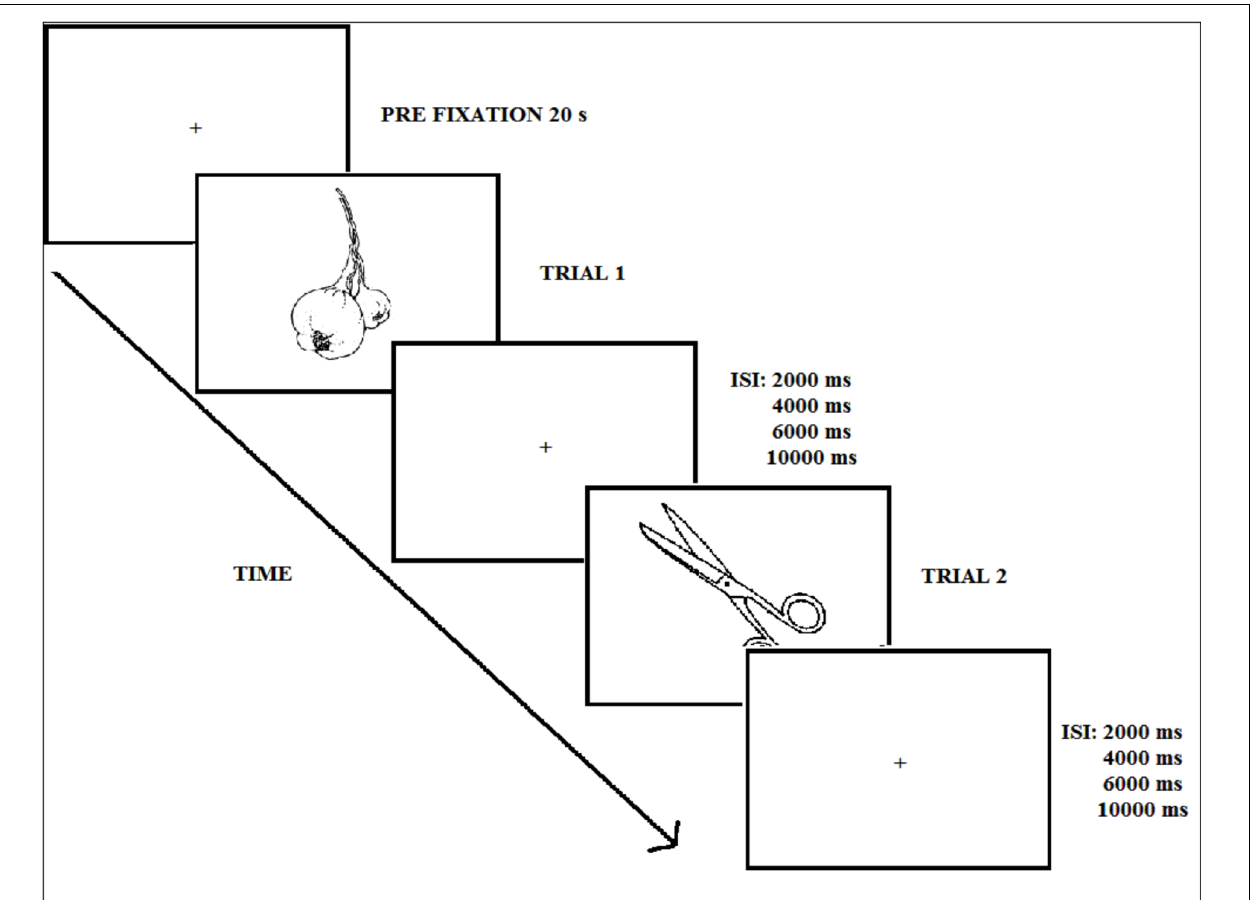
FIGURE 3 | Experimental procedure during the test phase (Experiments 1 and 2); ISI refers to the inter-stimulus